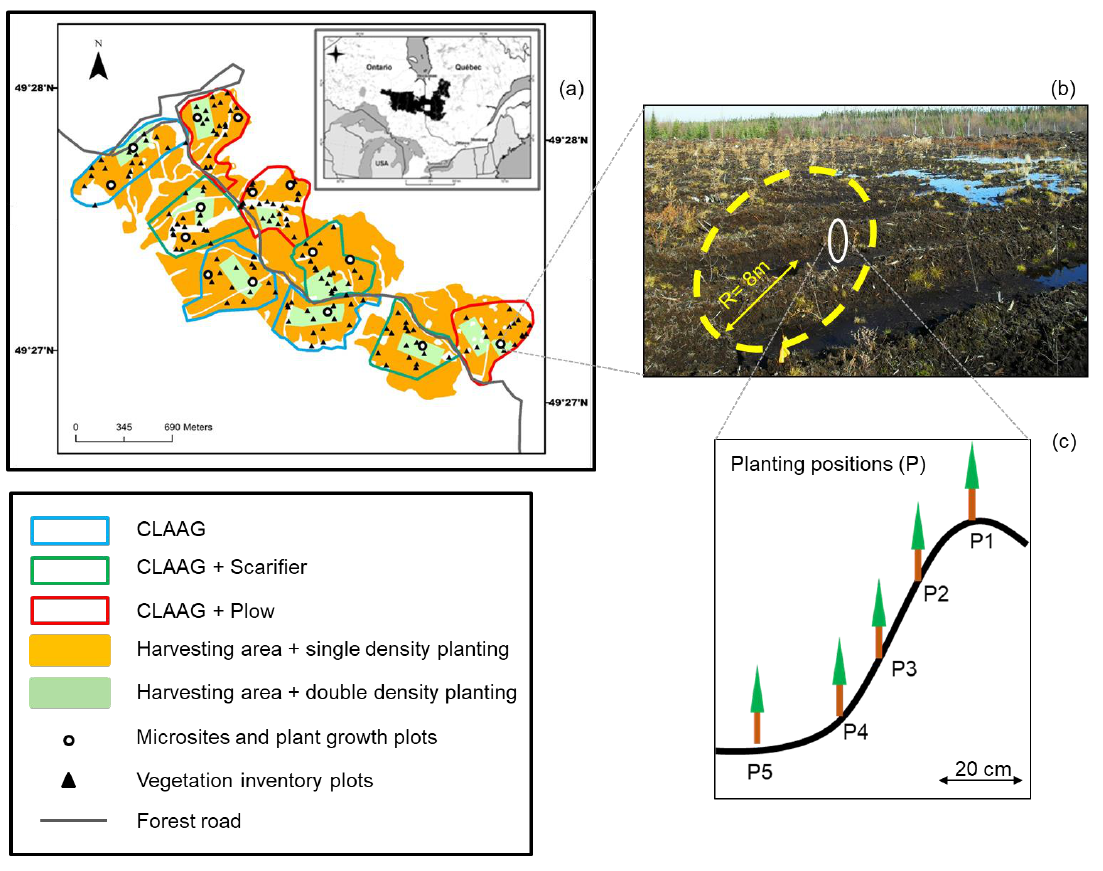
Figure 1. ( a ) Location of the study area (inset), distribution of the silvicultural treatments (careful logging around advance growth (CLAAG) without mechanical site preparation (MSP), CLAAG + scarifier, CLAAG + plowing), distribution of microsite and plant growth plots, and vegetation plots over the nine main cut block, and planting densities single (2200 stem per ha) and double (5000 stem per ha); ( b ) An inventory plot 8 m in radius; ( c ) Planting positions along a furrow (P1 higher to P5 lower) after mechanical site preparation.